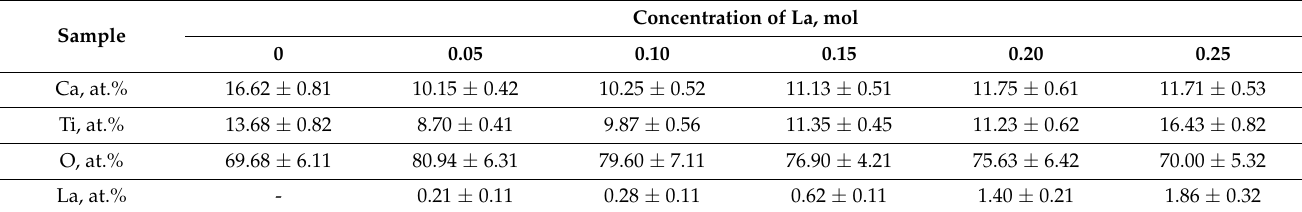
Table 2. Data of elemental analysis.